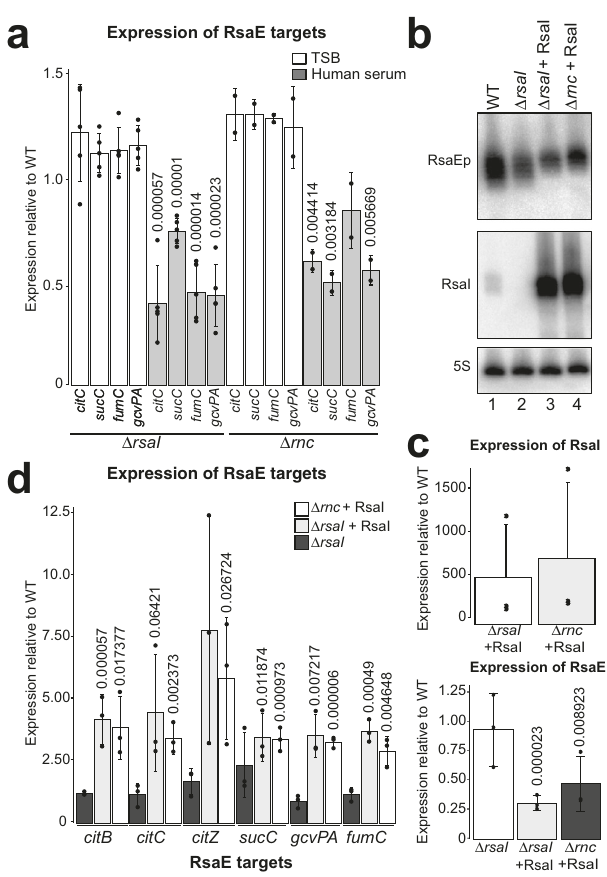
Fig. 5 RsaI and RNase III regulate RsaE activity in human serum. a RsaI and RNase III regulate RsaE activity in human serum. Shown is the expression of RsaE targets in TSB and human serum in the Δ rsaI and Δ rnc strains relative to the parental strain (USA300) as measured by RT-qPCR. Averages and standard deviation were calculated from fi ve ( Δ rsaI ) or two ( Δ rnc ) experimental replicates and three technical replicates. Values above bars display respective p value (mutant vs WT), obtained from Student ’ s two-tailed, unpaired t test The bar fi ll denotes the condition tested, white for TSB, grey for human serum. b Overexpression of RsaI and impact on the levels of RsaE. Strains (WT, Δ rsaI and Δ rsaI complemented with a plasmid expressing RsaI) were grown to OD 600 ~3.0 in TSB and RNA was analysed by Northern blot analyses to detect RsaE, RsaI and 5 S rRNA. RsaEp indicates processed RsaE. Shown is a representative Northern blot results from three independent experiments. c Quanti fi cation of RsaI and RsaE Northern blot results described in b . Shown are the averages and standard deviations calculated from three independent experiments. d Expression of RsaE targets in Δ rnc and Δ rsaI strain complemented with a plasmid expressing RsaI. Shown are the averages and standard deviations calculated from three independent experiments. Values are represented as relative to the WT. Values above bars display respective p value (mutant vs WT), obtained using Student ’ s two-tailed, unpaired t test. The bar fi ll denotes the tested strain; dark grey for Δ rsaI , light grey for Δ rsaI pICS3:RsaI and white for Δ rnc pICS3:RsaI. Images and raw data used to generate these results are provided in the Source Data fi an RNase III deletion mutant ( Δ rnc ). Deleting RNase III almost completely abolished haemolytic activity (Fig. 6e).